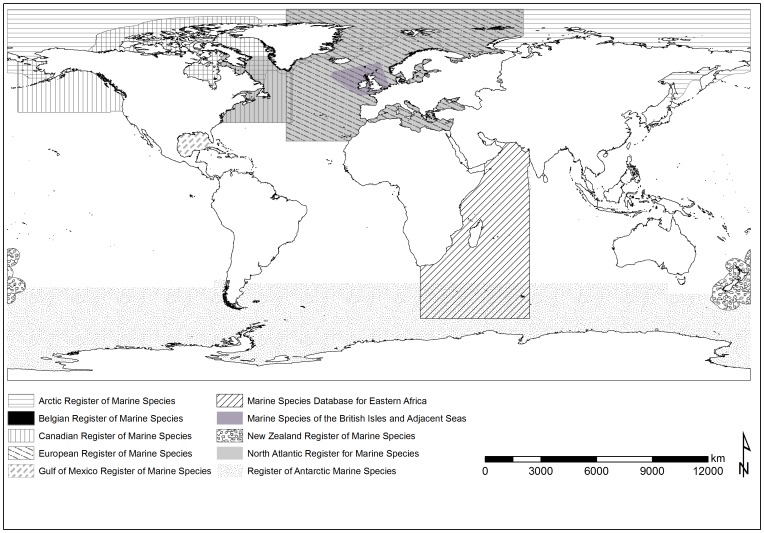
The approximate present geographic coverage of the larger Regional Species Databases (i.e. all-species inventories) within WoRMS.